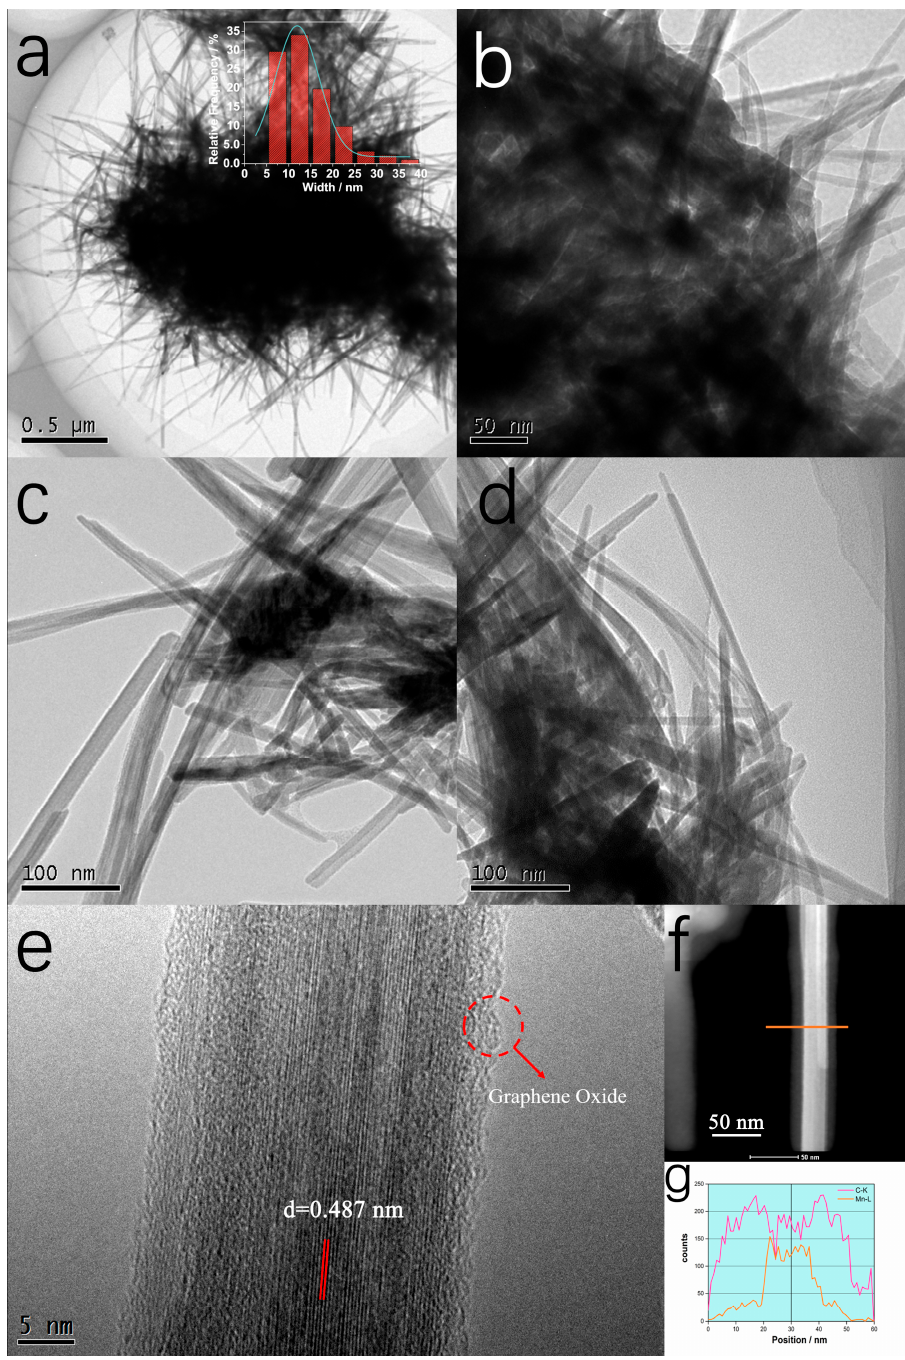
Figure 3. ( a – d ) TEM (transmission electron microscope) images of MnPO 4 ∙ H 2 O